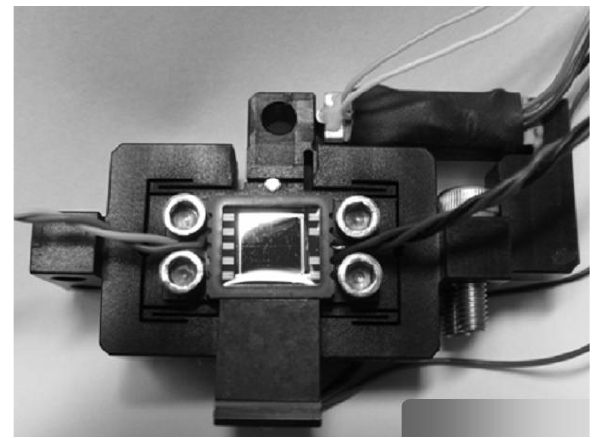
Figure 7. Photo of the s -scanner inside of the